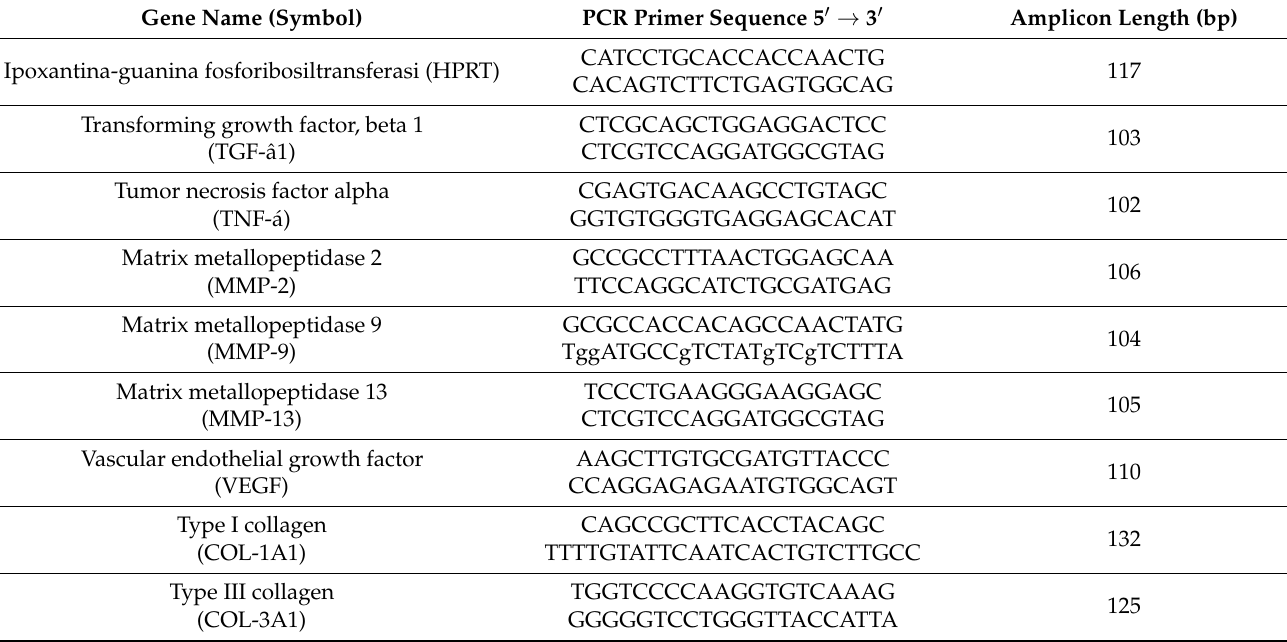
Table 2. Primers sequence used for qRT-PCR